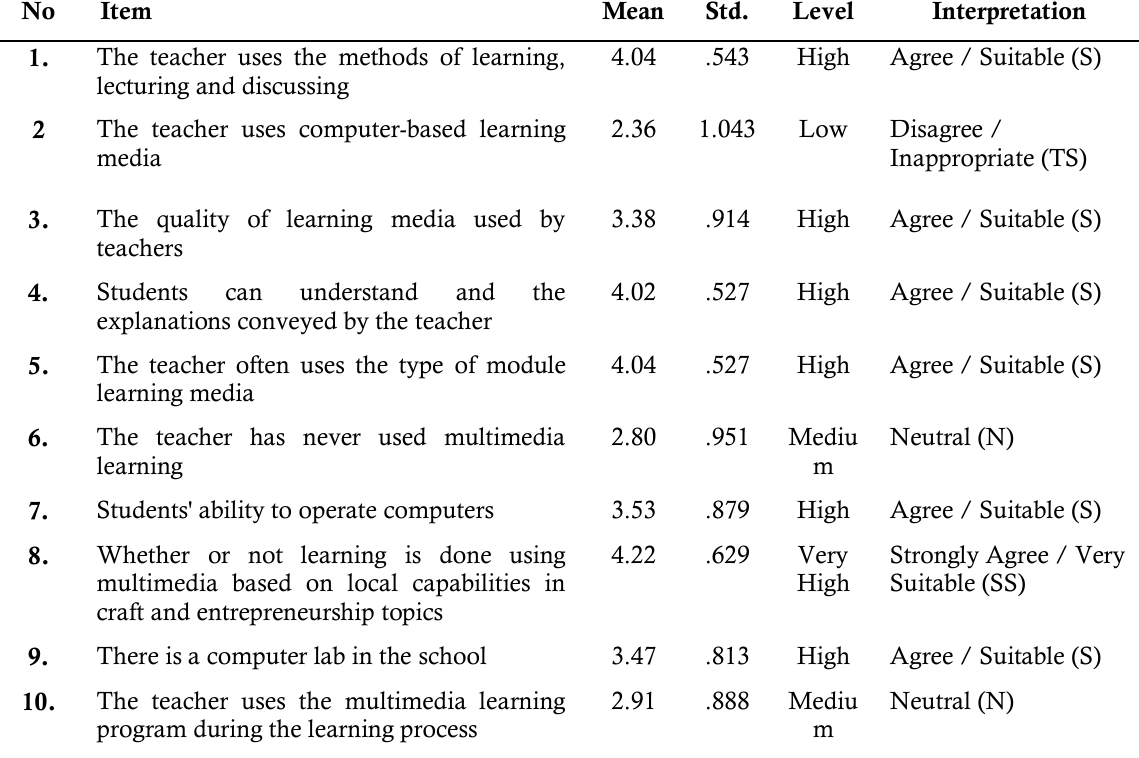
Tabel 2. Results of Identification of Analysis Needs for Developing Learning